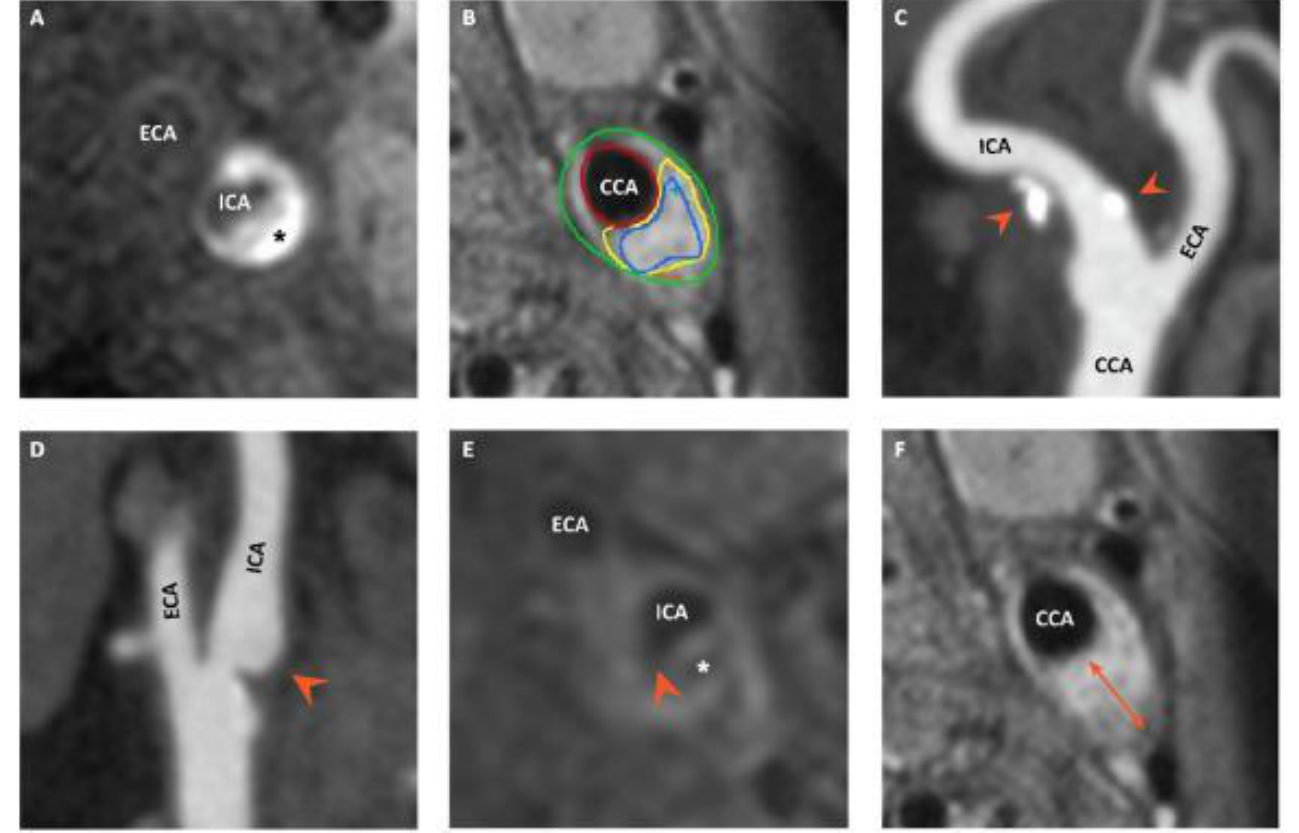
Figure 1. ( A ) Axial view of a 3D T1-weighted fast spoiled gradient echo MR image showing a high-intense signal (asterisk) indicative of intraplaque hemorrhage. ( B ) Axial view of a carotid plaque depicted with 3D T1-weighted pre-contrast quadruple inversion recovery MR, which is delineated to measure different plaque components. The part surrounded with a yellow line is a lipid-rich necrotic core. ( C ) CTA image showing several calcifications (arrow heads) in a carotid plaque of the ICA. ( D ) CTA image with contrast material reaching into a carotid plaque (arrow head), which indicates plaque ulceration. ( E ) Post-contrast T1-weighted fast spin echo MR image, which shows an interrupted signal (arrow head) between the lipid-rich necrotic core (asterisk) and the lumen of the ICA. ( F ) The orange arrow in this 3D T1-weighted pre-contrast quadruple inversion recovery MR image represents the maximum vessel wall area of this carotid plaque. CCA = common carotid artery, ECA = external carotid artery, and ICA = internal carotid artery. These images and legends were previously published by Van Dam-Nolen et al. as part of another PARISK paper [12].